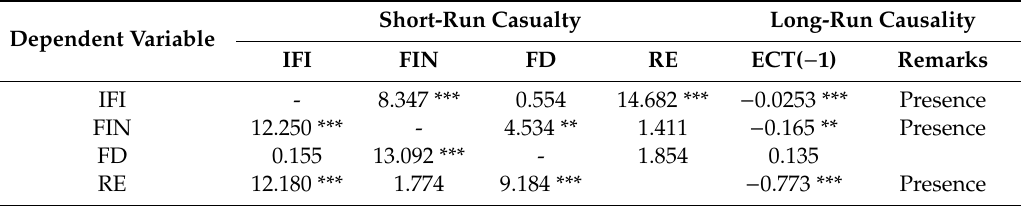
Table 9. Causality test with GMM